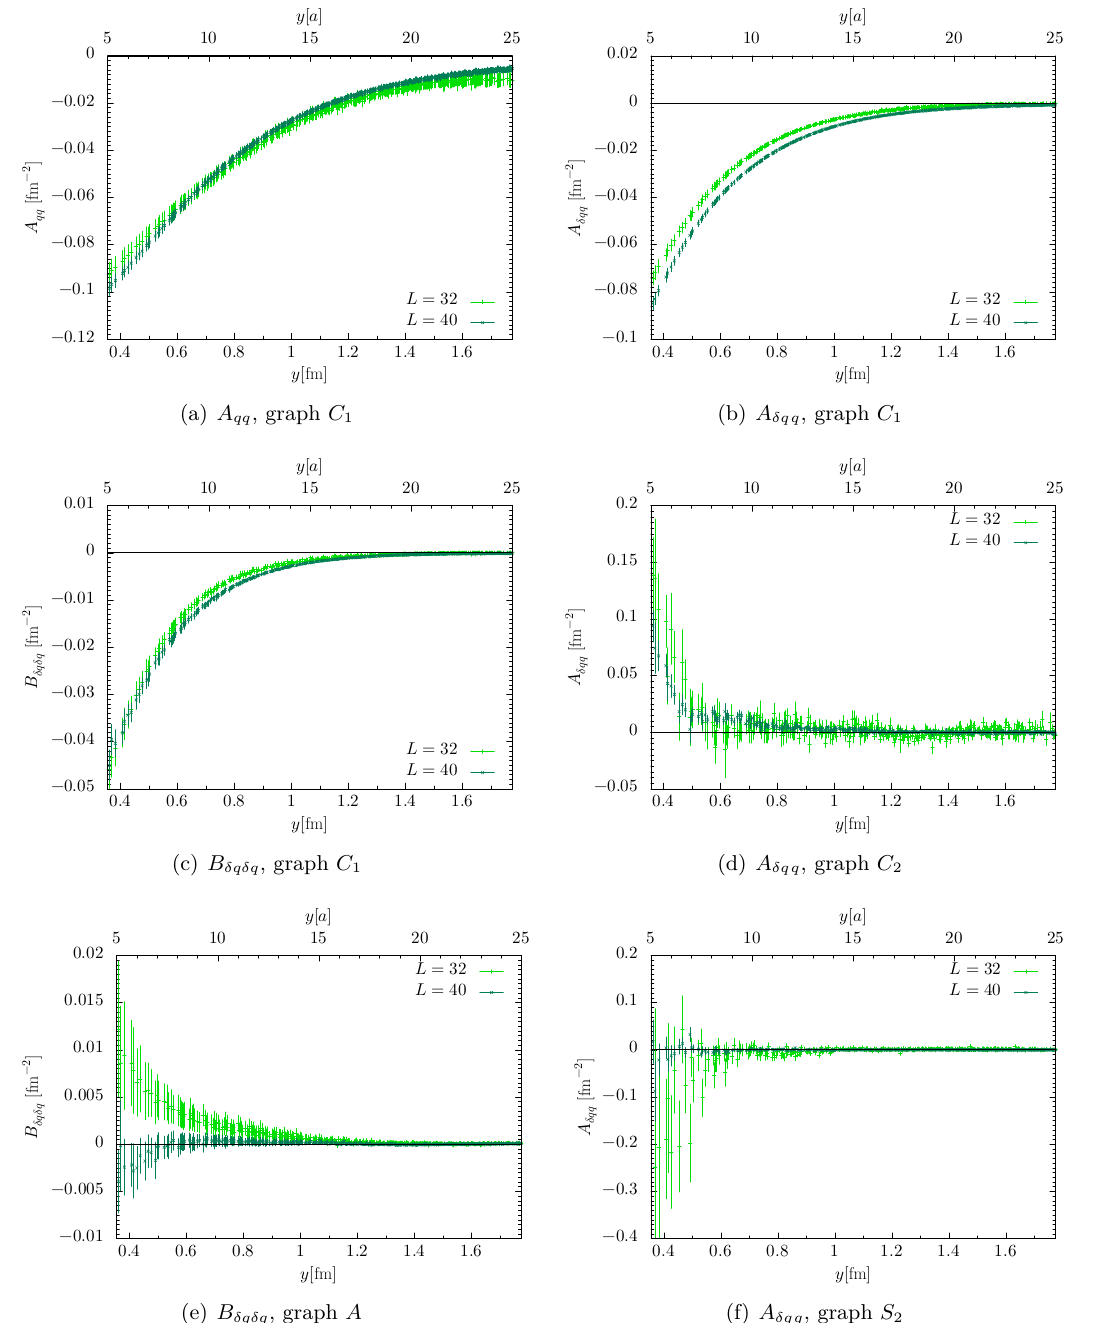
Figure 11 . Comparison of data for the two different lattice sizes in our study. All points are for zero pion momentum, light quarks, and subject to the cut